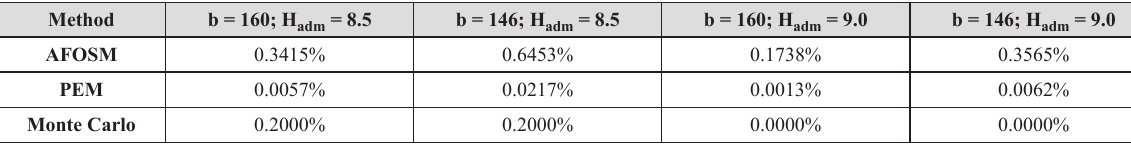
Resume of risk analysis